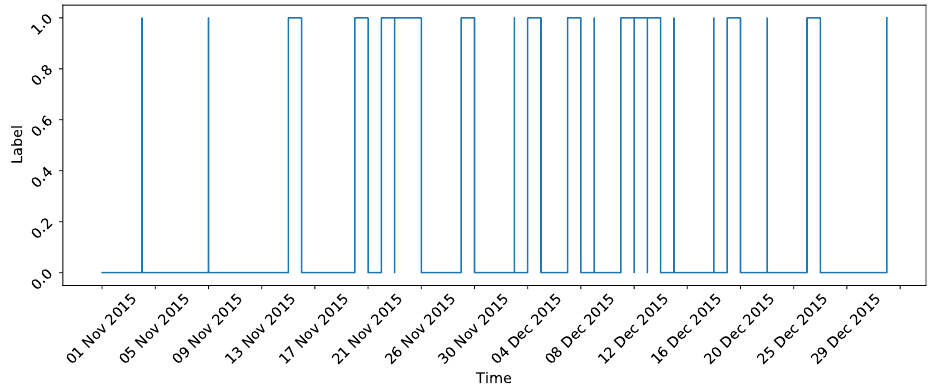
Figure 6. Labeled information for one turbine. Label 0: normal; Label 1: blade icing.